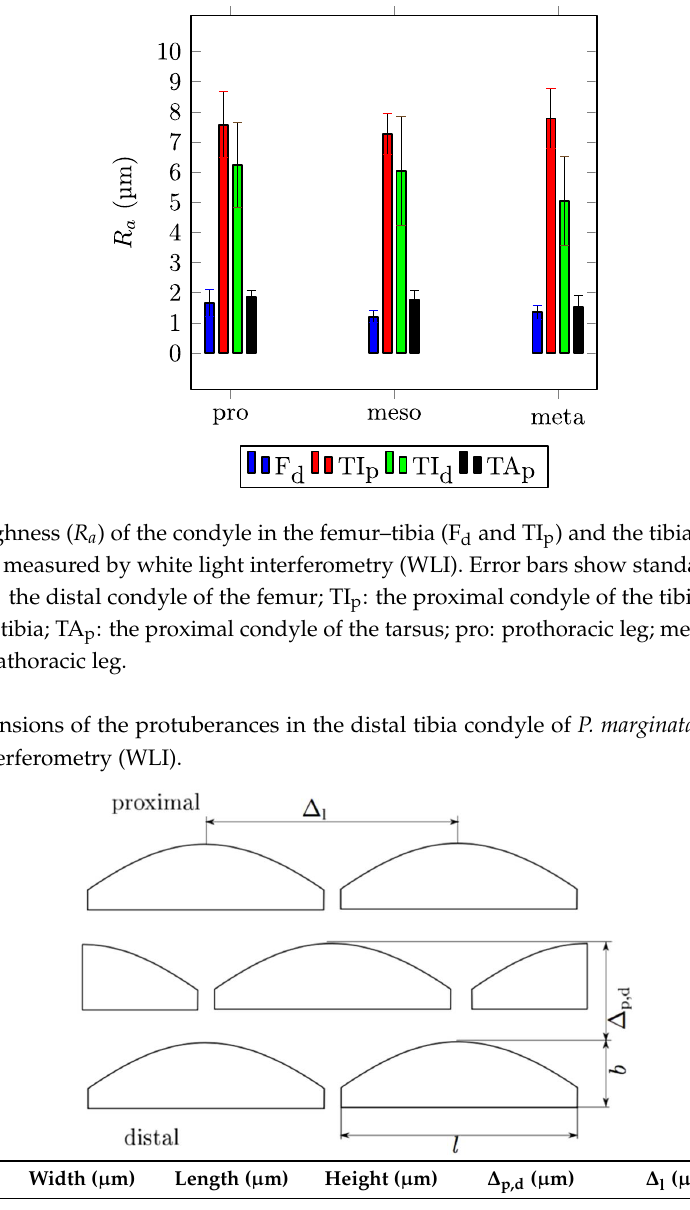
Table 1. Dimensions of the protuberances in the distal tibia condyle of P. marginata measured with white light interferometry (WLI).